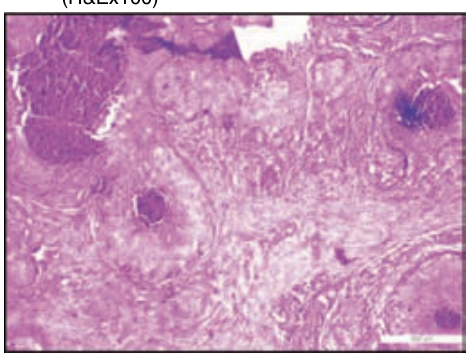
Fig.4. Myxosarcoma - resembled mesenchyme and contained undifferentiated cells (H&Ex100)